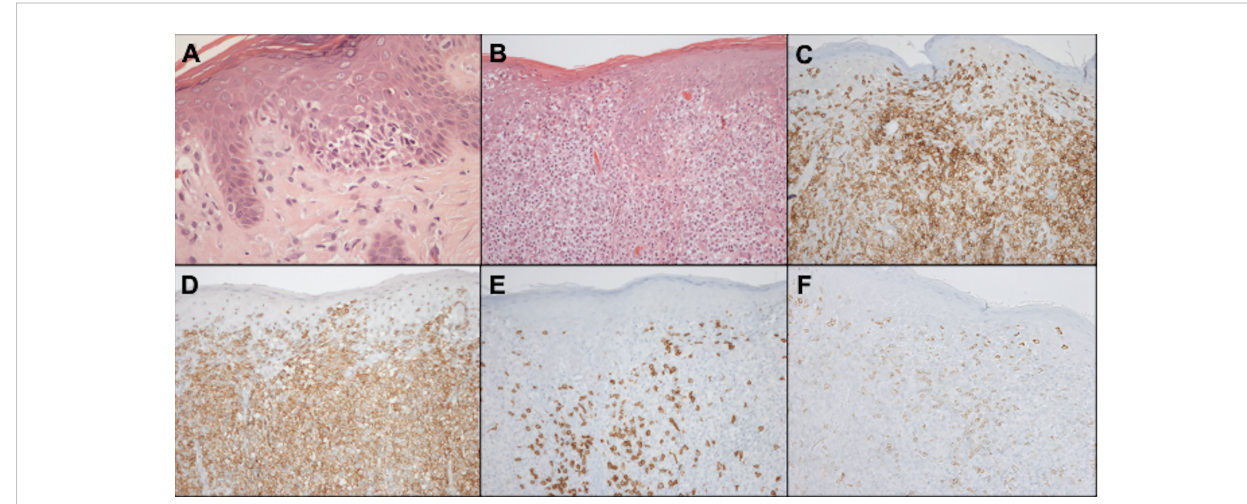
FIGURE 11 Histopathology and immunohistochemistry of the skin. Epidermotropism of atypical lymphocytes, hematoxylin-eosin staining at 400x magni fi cation (A) . Exuberant atypical in fi ltrate affecting the epidermis and dermis, hematoxylin-eosin at 200x magni fi cation (B) . CD3 positivity, demonstrating that epidermal and dermal cells correspond to T-lymphocytes, 200x magni fi cation (C) . CD4 positivity, 200x magni fi cation (D) . Expression of CD8 on small reactive cells, 200x magni fi cation (E) . Loss of CD7 expression in CD4-positive neoplastic T cells, 200x magni fi cation (F)